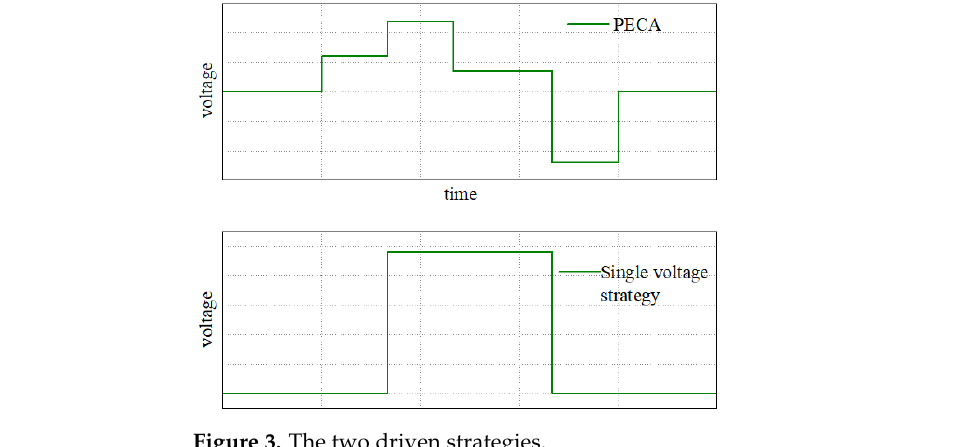
Figure 3. The two driven strategies.